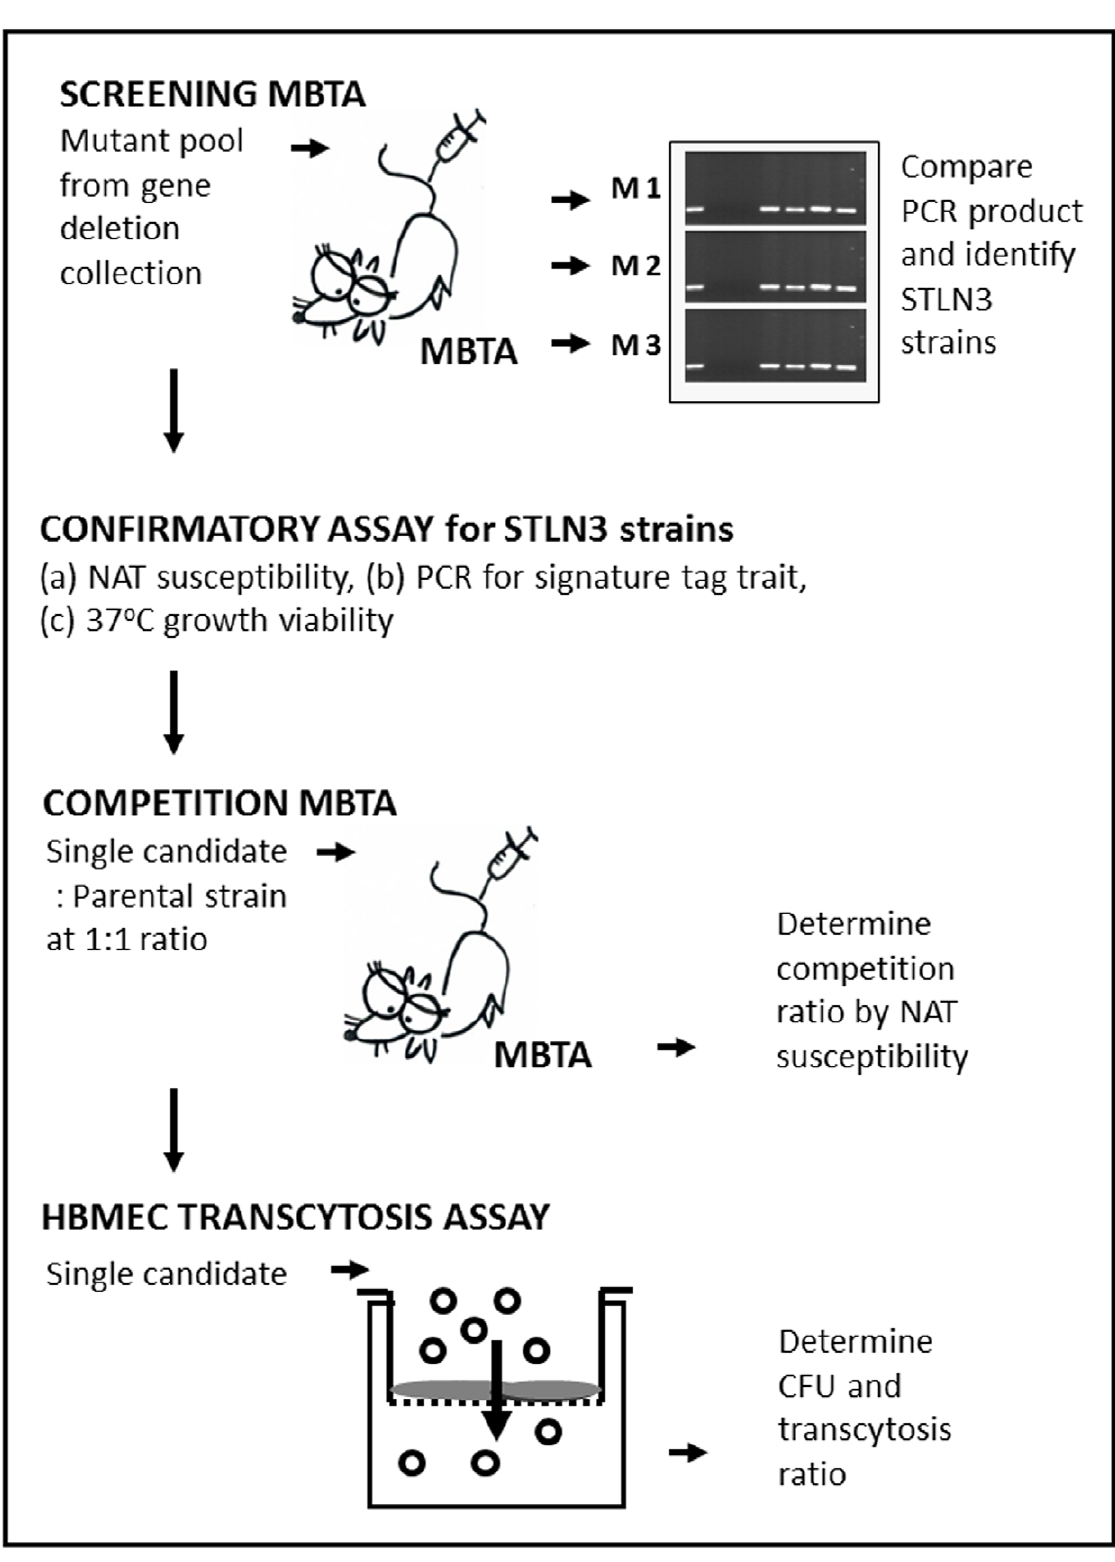
Figure 1. The overall chart of strategy. The screen and identification of Cryptococcus neoformans mutants for CNS transmigration phenotype in this study through MBTA and HBMEC are shown. Abbreviation: MBTA: Mouse brain transmigration assay, HBMEC: human brain microvascular endothelial cells, NAT: nourseothricin acetyltransferase, M1: first mouse, M2: second mouse, M3: third mouse, STLN3: signature tag loss number is three in all three mice.